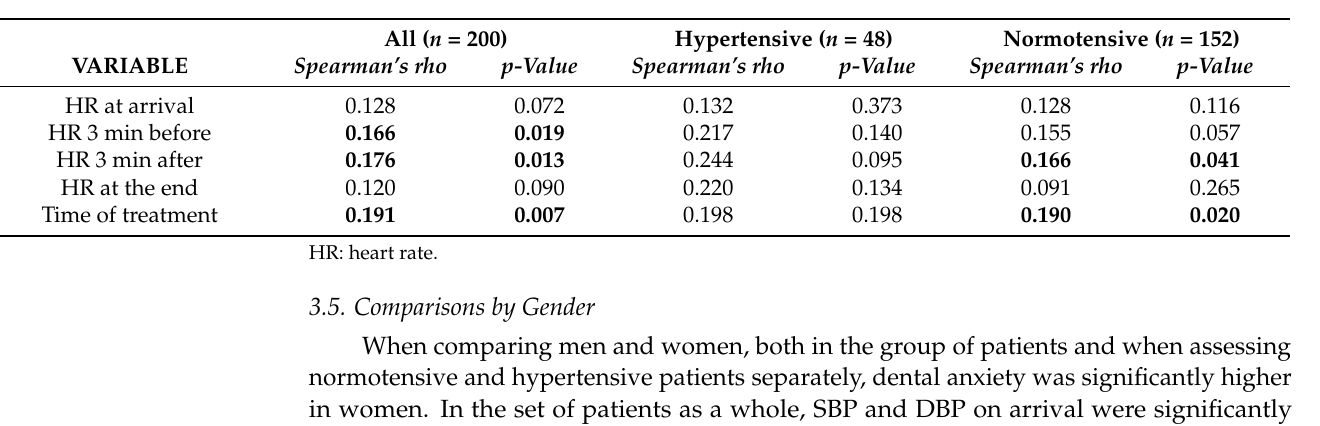
Table 3. Correlations between the Corah Dental Anxiety Scale score and HR and time of treatment.